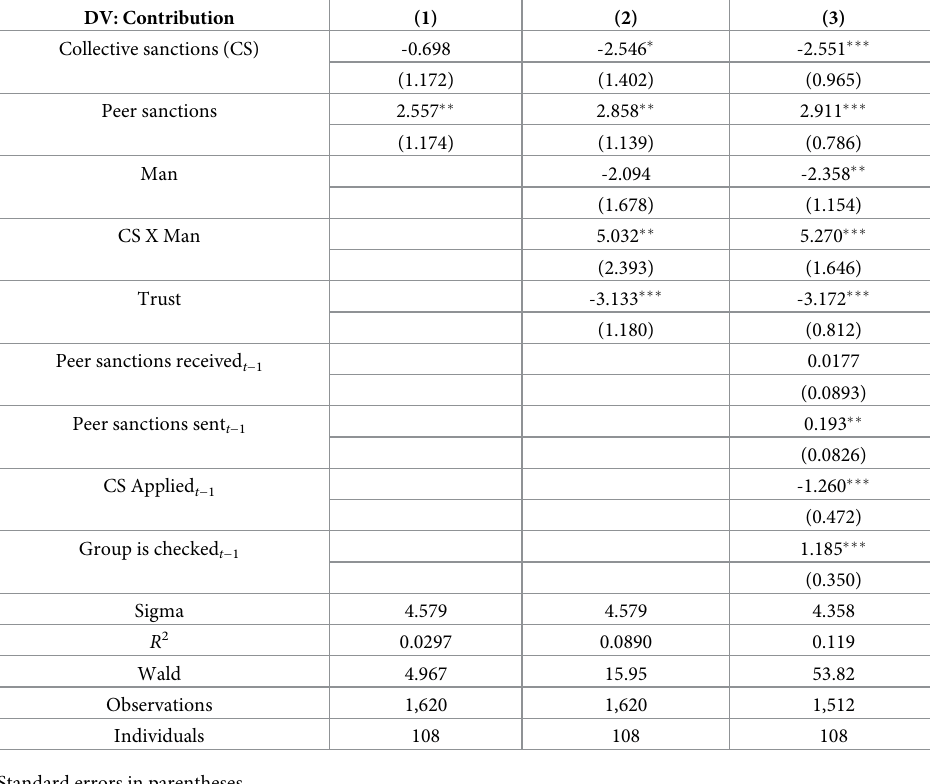
Table 6. DV: Contribution to the group project. Panel OLS (random-effect) baseline and two extended models. DV: